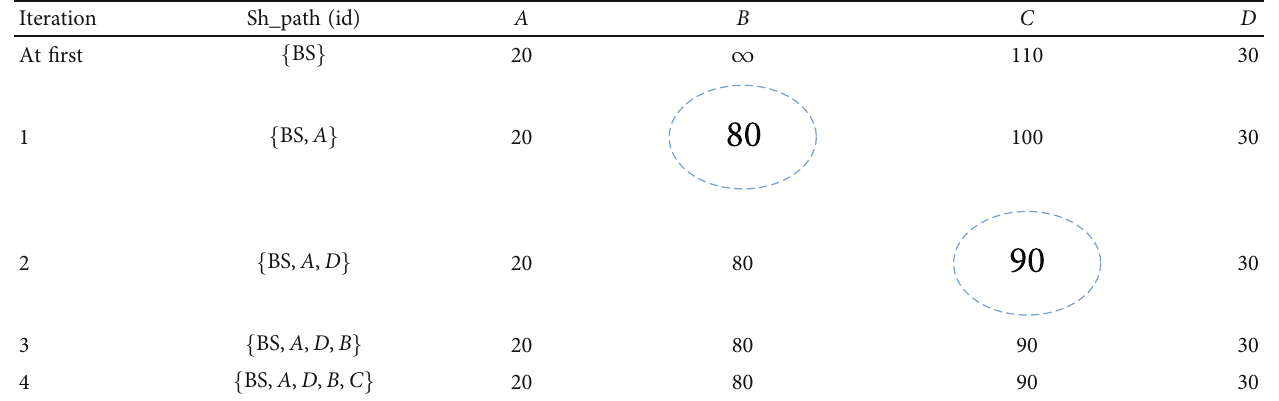
Table 1: Shortest path iteration.